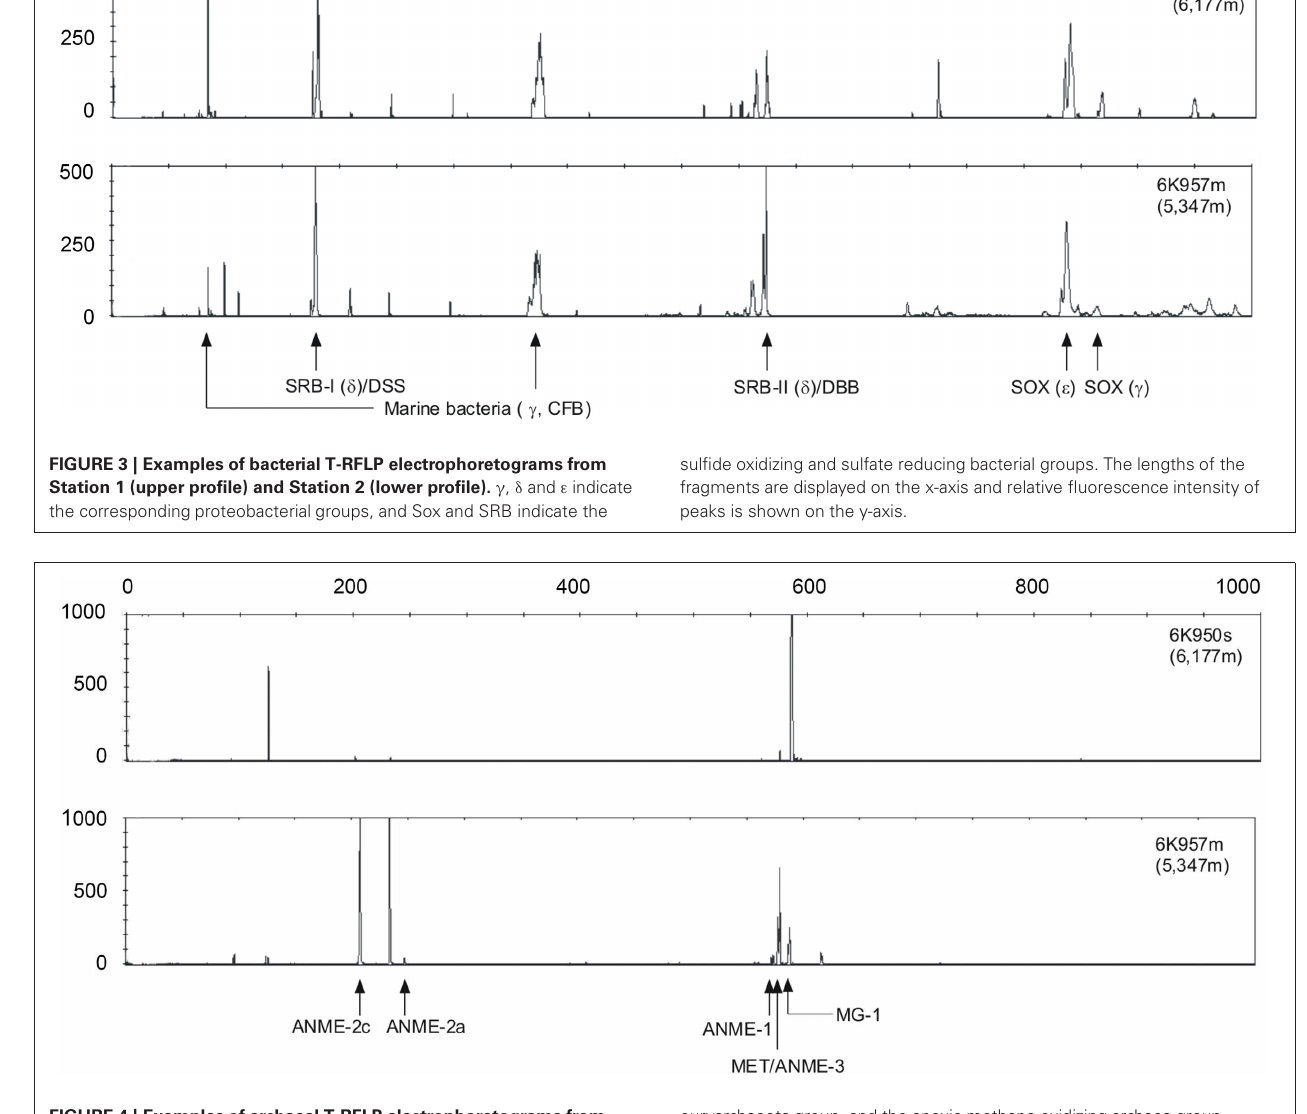
FIGURE 4 | Examples of archaeal T-RFLP electrophoretograms from Station 1 (upper profile) and Station 2 (lower profile). MG-I, MET and ANME indicate the crenarchaeota marine group I, the methanogenic